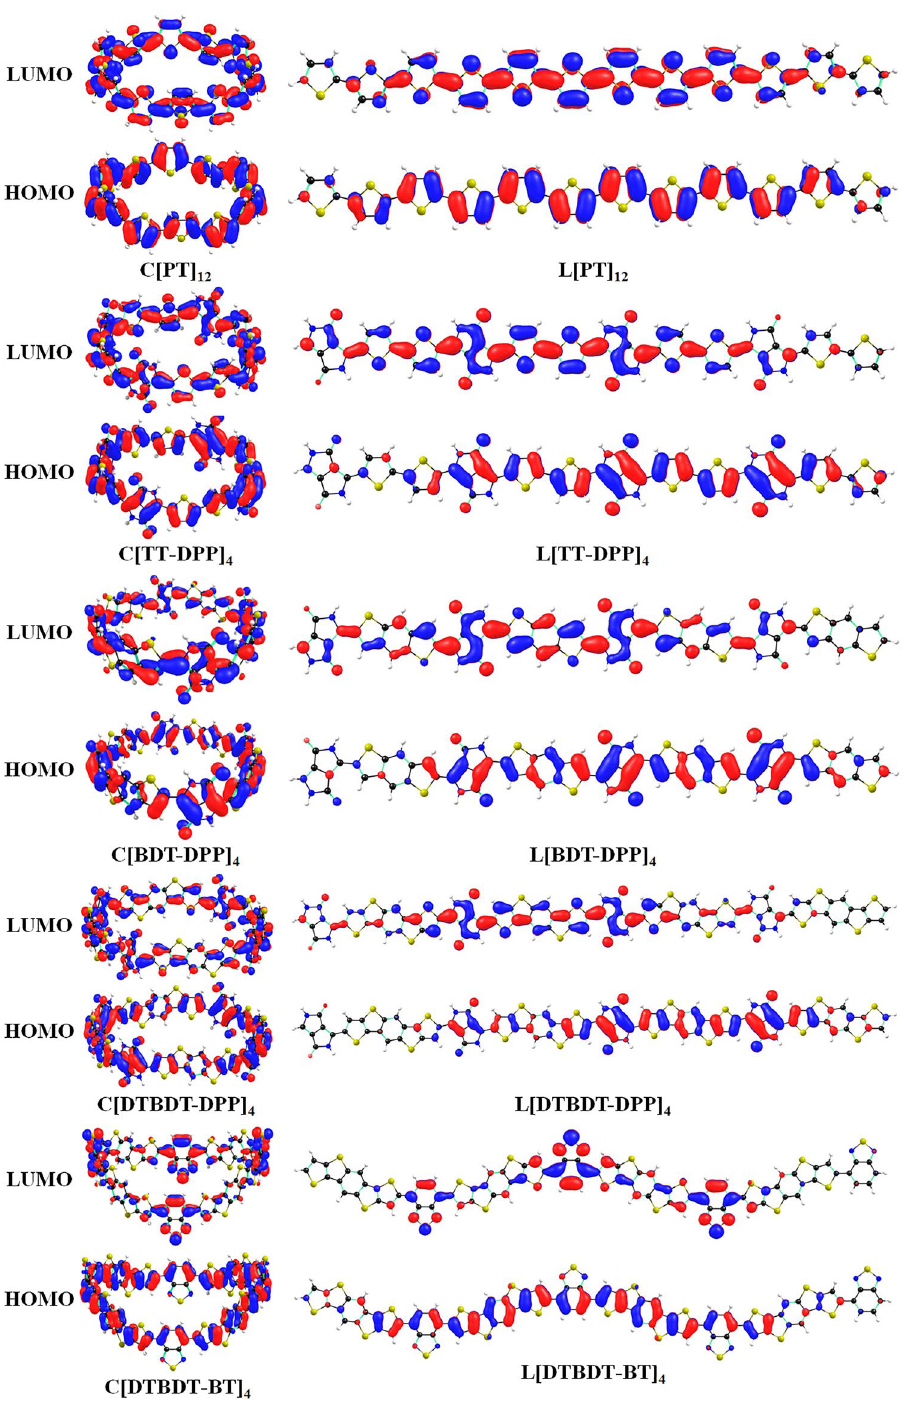
Figure 3. Pictorial representation of HOMO and LUMO wave functions of cyclic (C[PT] 12 , C[TT-DPP] 4 , C[BDT-DPP] 4 , C[DTBDT-DPP] 4, and C[DTBDT-BT] 4 ) and linear (L[PT] 12 , L[TT-DPP] 4 , L[BDT-DPP] 4 , L[DTBDT-DPP] 4, and L[DTBDT-BT] 4 ) molecules obtained at mPW1PW91/6-31G(d,p) level of